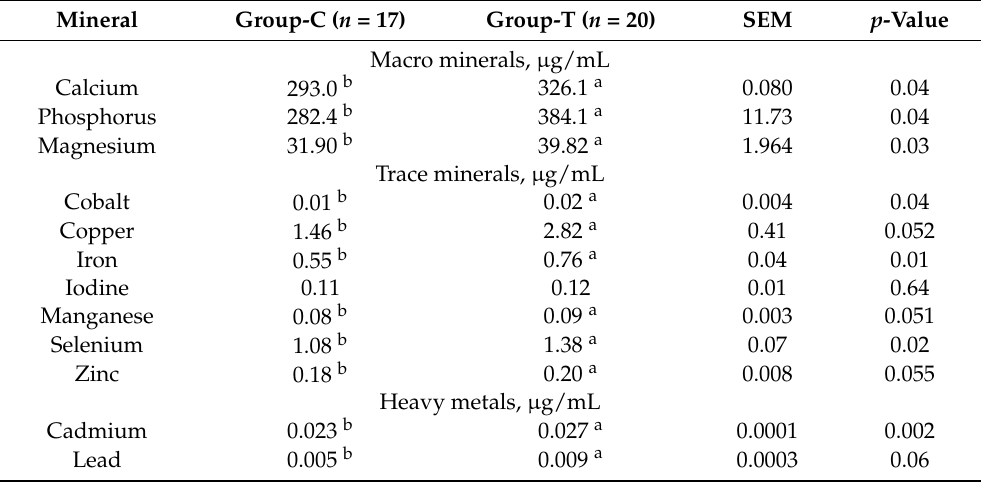
Table 5. Elements concentration (ug/mL) in blood serum of calves s raise in a semi-intensive system during